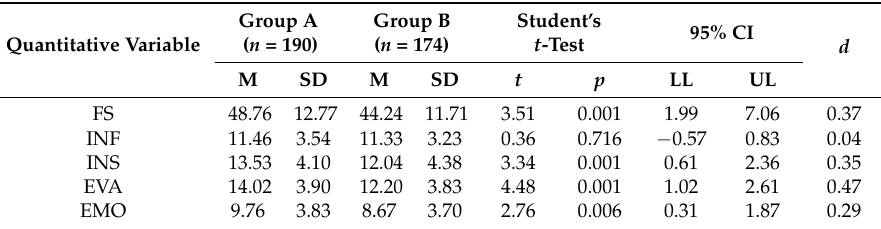
Table 3. Comparison of the results of functional